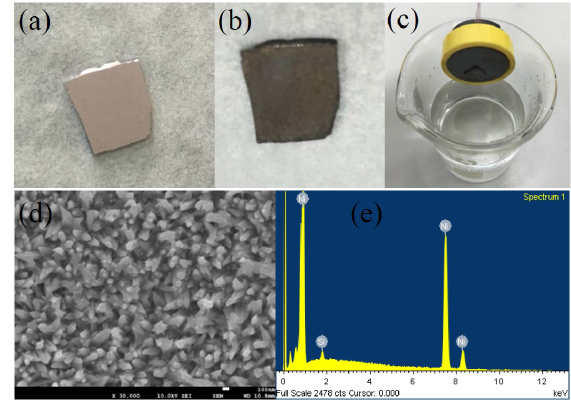
Figure 3: Photos of Si foil before Ni-plating (a), after Ni-plating (b), absorbed by a magnet after Ni-plating, and SEM image (d) of Ni- coated Si foil surface and the corresponding EDS result (e).